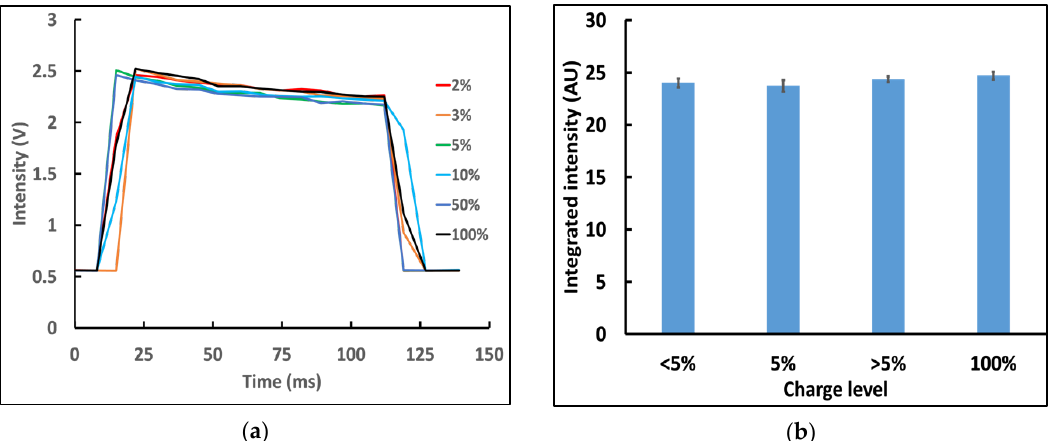
Figure 3. Plugging into the charger makes the iPhone 6s flash more consistent. ( a ) Variations of flash intensity (437 nm) at different charge levels while plugged into the charger. ( b ) Integrated flash intensity over the duration of the flash. When plugged in, the iPhone 6s had consistent flash output regardless of battery charge (n = 3).